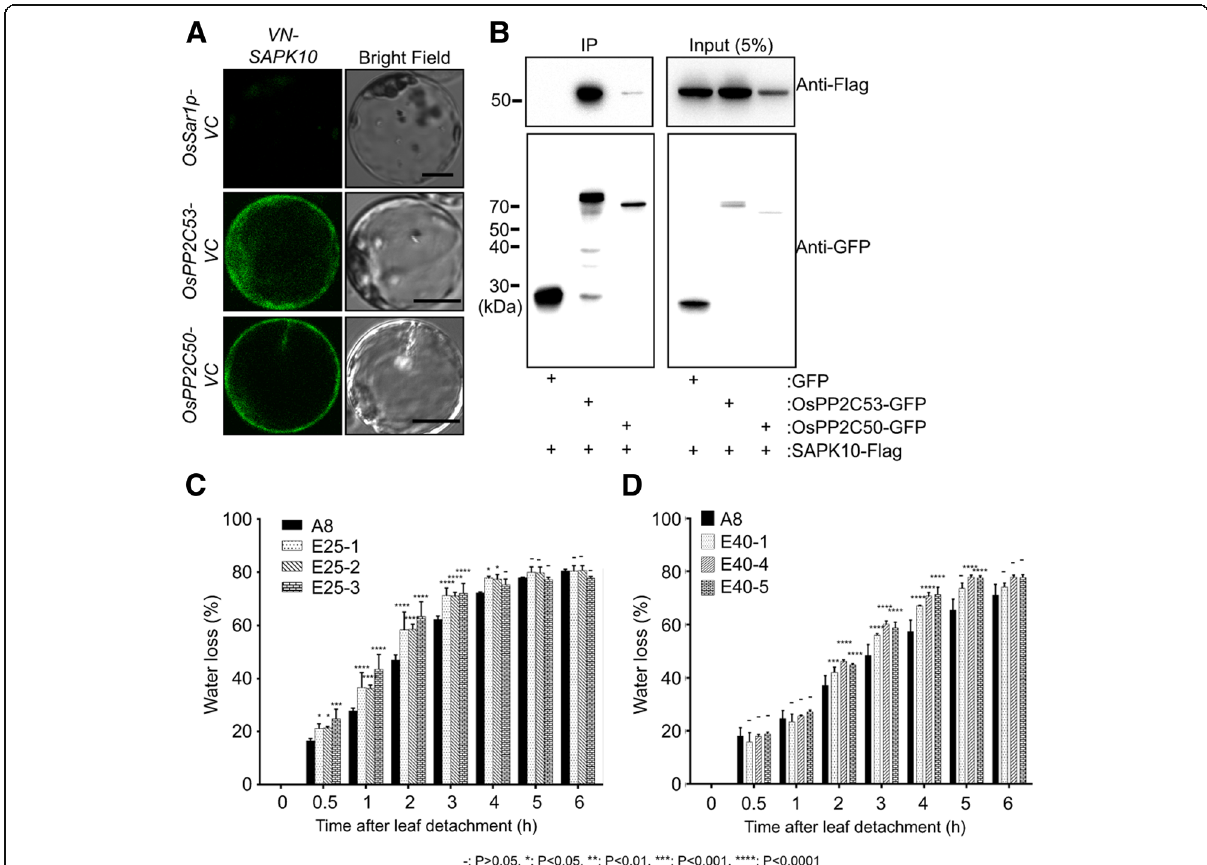
Fig. 5 OsPP2C50 and OsPP2C53 physically interact with SAPK10 and their overexpression promotes water loss. a BiFC analysis of VN-SAPK10 and OsPP2C53-VC or OsPP2C50-VC. OsSar1p-VC was used as a negative control. Scale bars are 10 μ m. b Co-IP analysis using OsPP2C53-GFP or OsPP2C50-GFP and SAPK10-Flag expressed in rice protoplasts. These experiments were repeated three times and a representative result was presented. c Water loss assays of OsPP2C53 -overexpressing transgenic lines (E25 – 1, 2 and 3) and control line (A8: empty vector transgenic plant). d Water loss assay of OsPP2C50 -overexpressing transgenic lines (E40 – 1, 4 and 5) and control line (A8: empty vector transgenic plant). The values depict the average and ± SD with 3 replications. ANOVA analyses were performed by comparing with water loss of A8